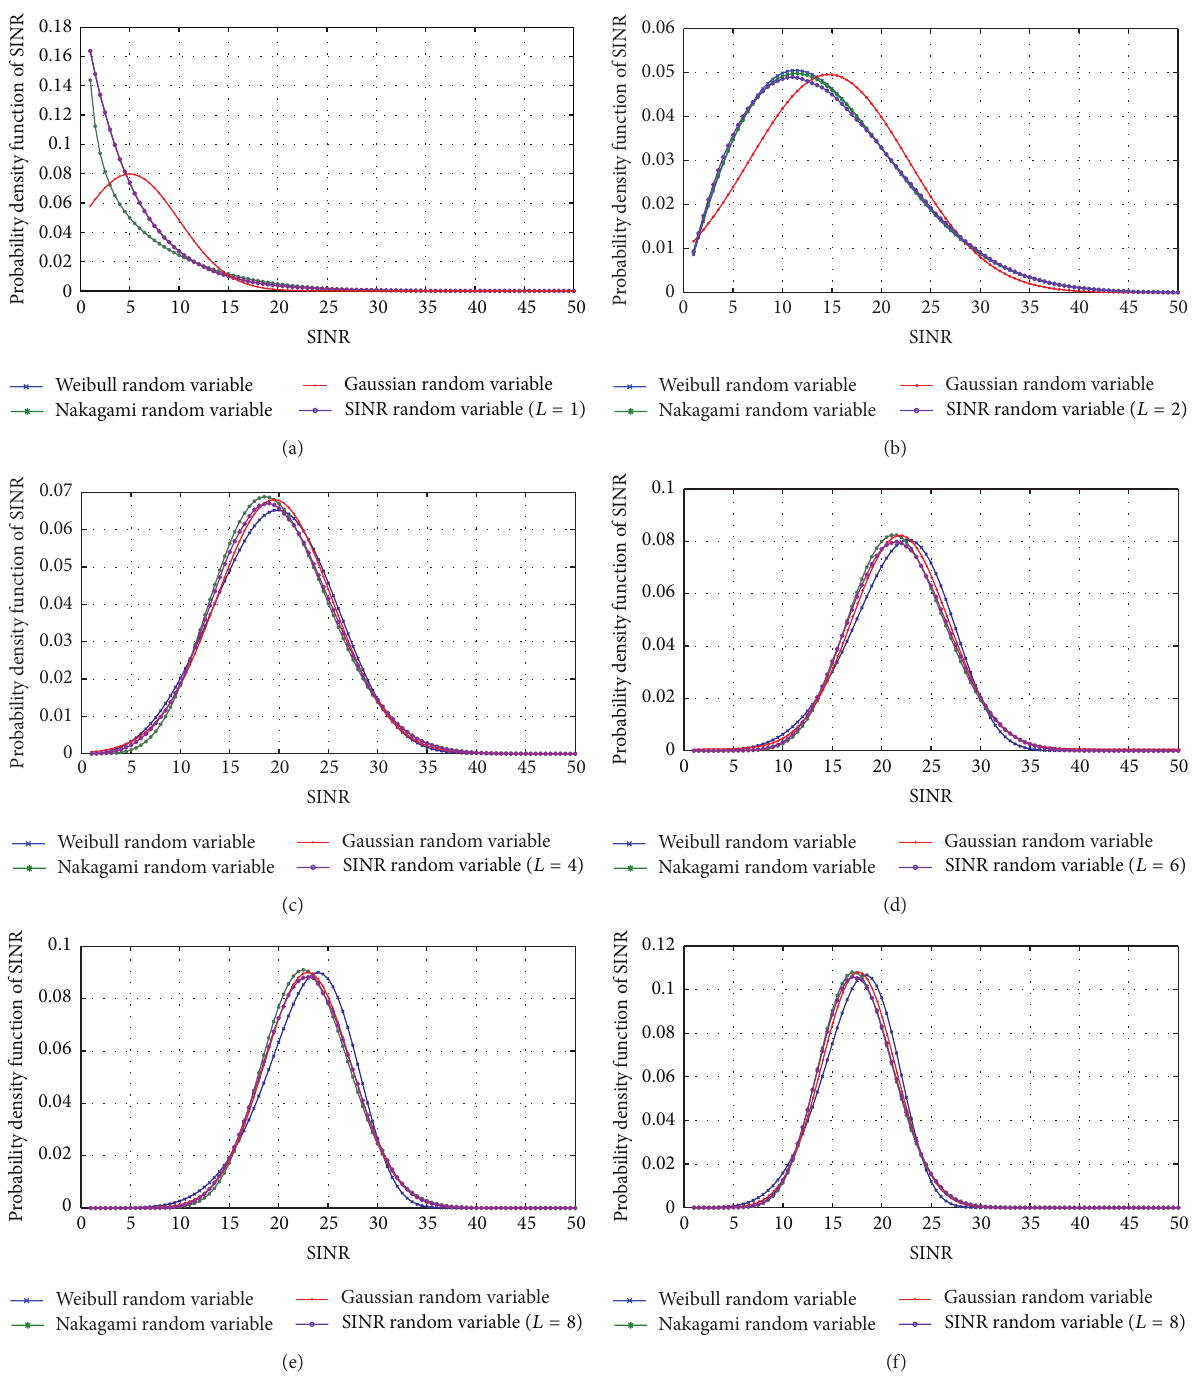
Figure 4: Comparison between the pdf of SINR random variable and the pdf of Weibull, Nakagami, and Gaussian random variables at different diversity orders ( 𝐿 = 𝑁